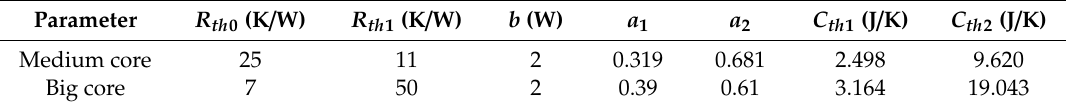
Table 5. Values of parameters describing Z thW ( t ) of inductors with cup cores.